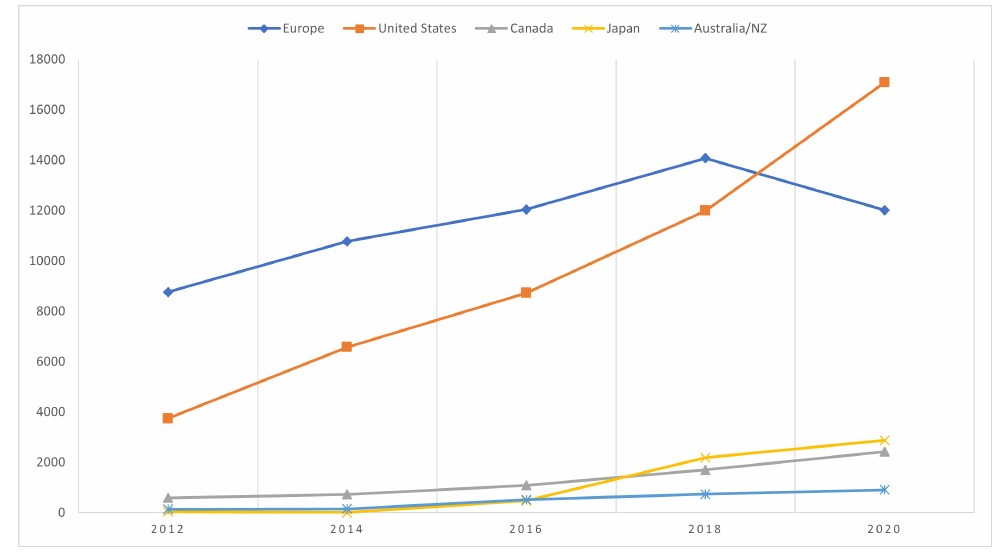
Figure A2. SRI assets by region 2012–2020. Source: GSRI.